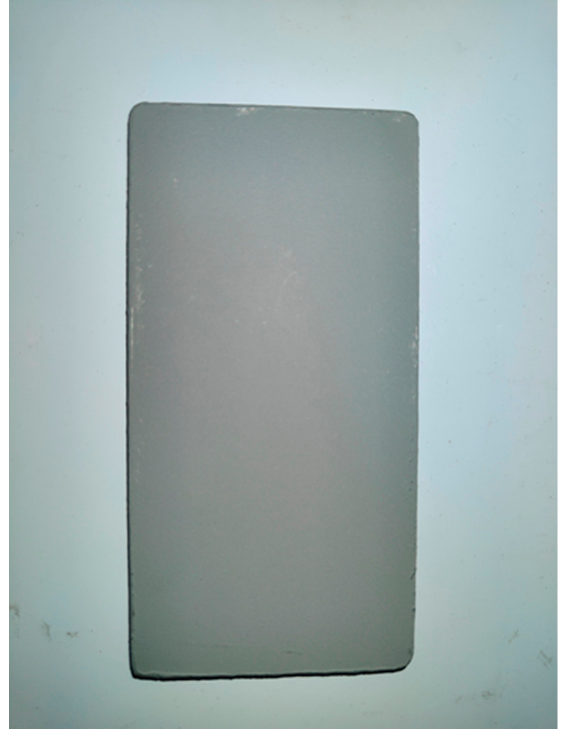
Figure 1. Image of a steel plate sample.